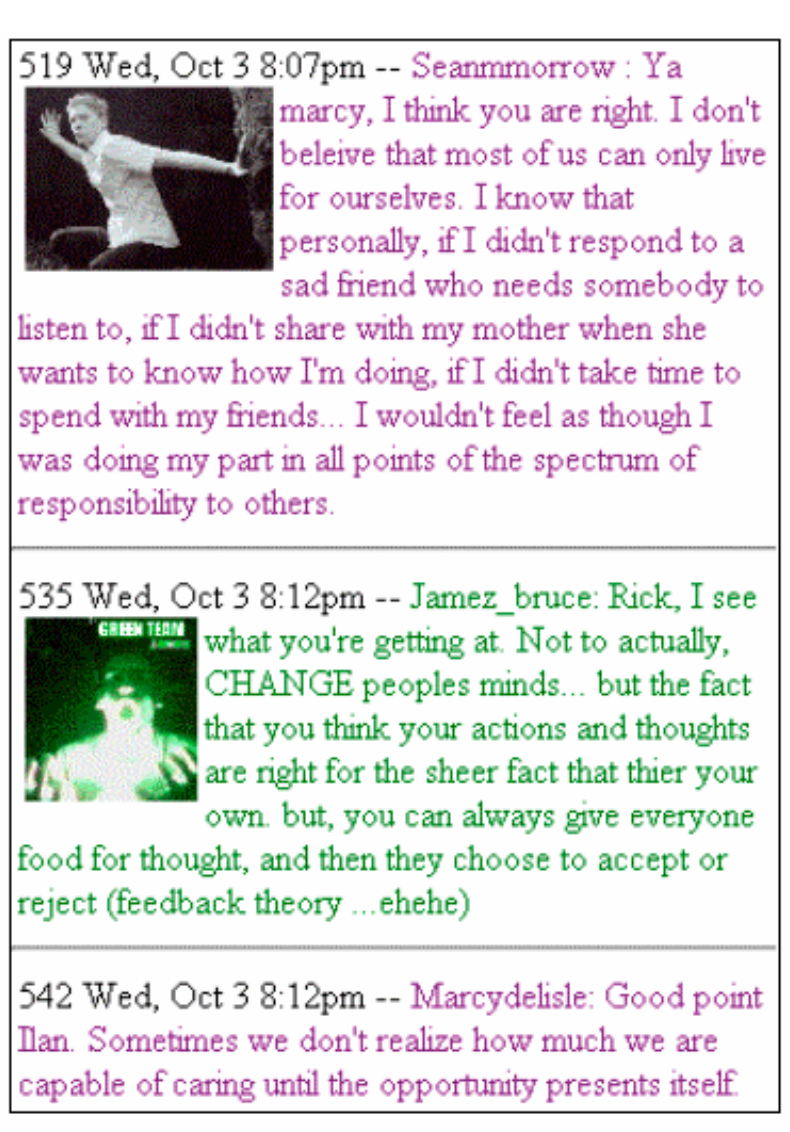
Figure 16. Examples of building on the knowledge of others